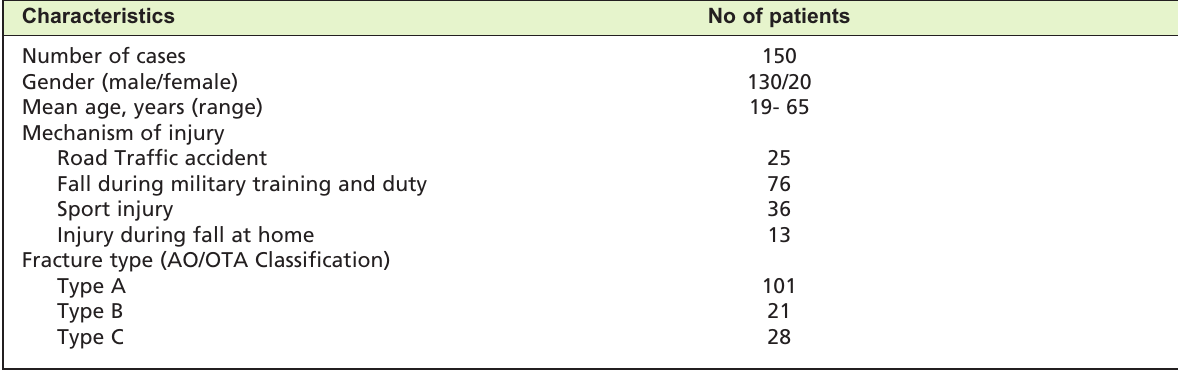
The characteristics of patients Table I: